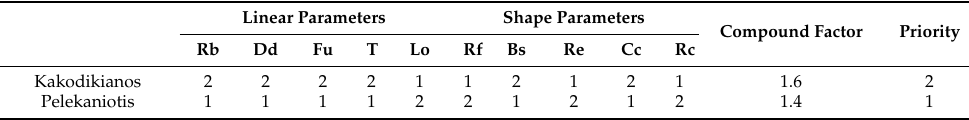
Table 14. Prioritization of catchments based on morphometric parameters.